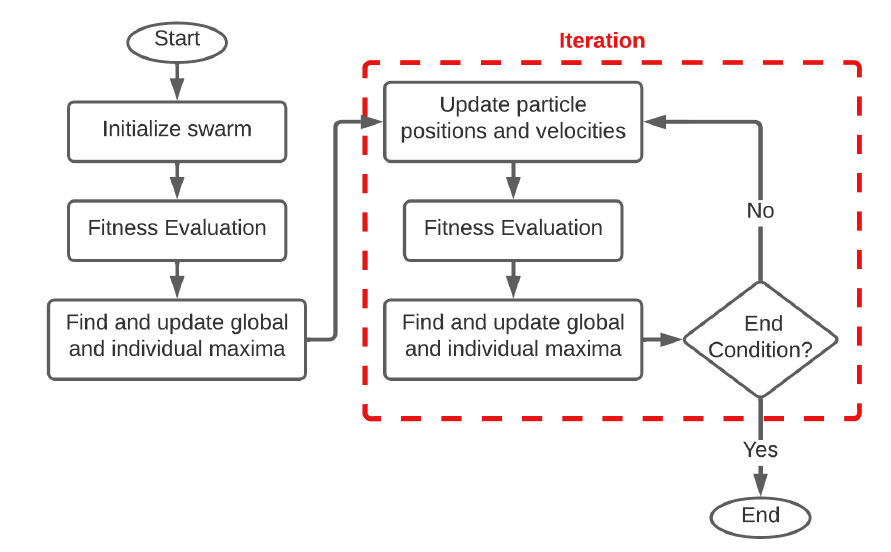
Figure 2. Particle swarm Optimization Flow Chart based on